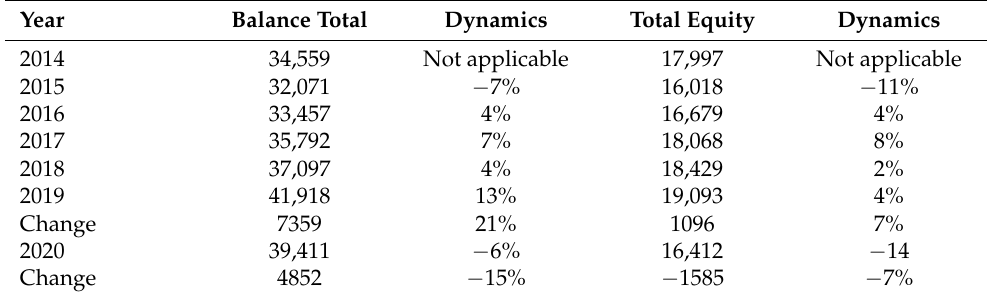
Table 5. Changes in the balance sheet total and equity of Tauron Capital Group in the years 2014–2020 (in PLN million).